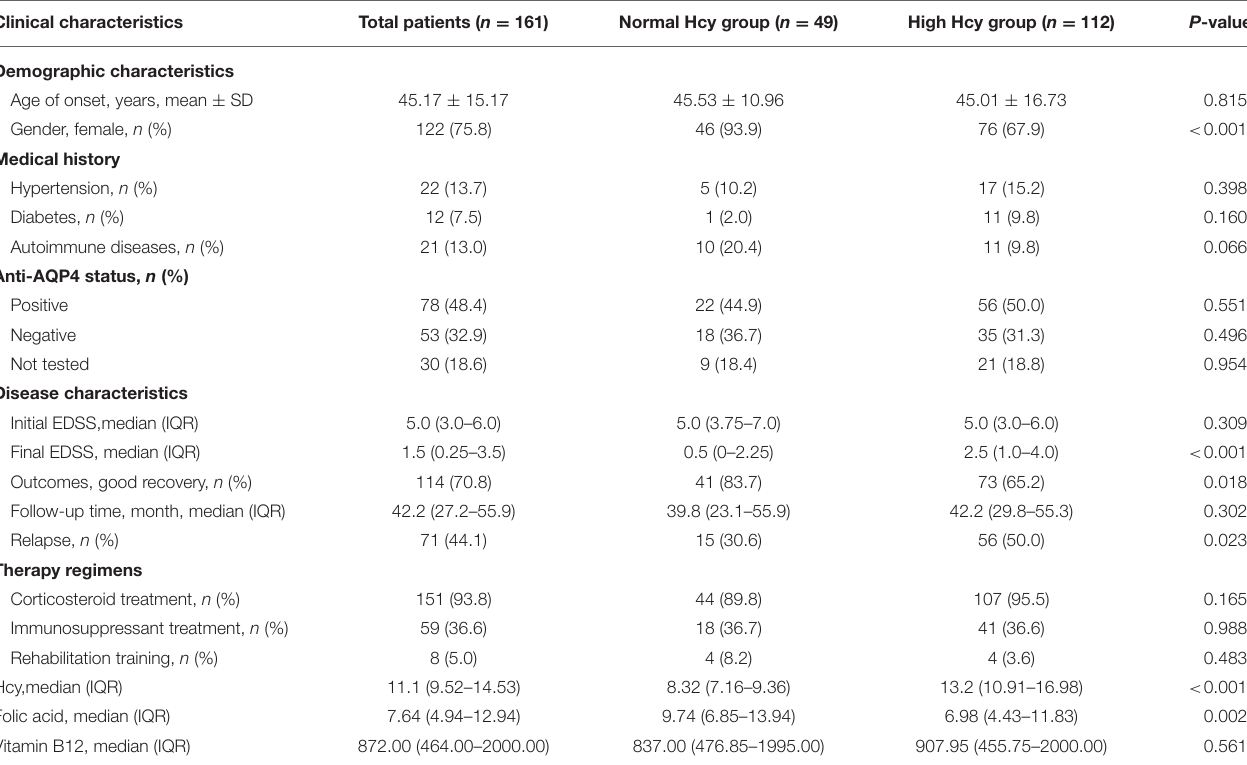
TABLE 1 | Demographic and clinical characteristics associated with categorized Hcy. Clinical